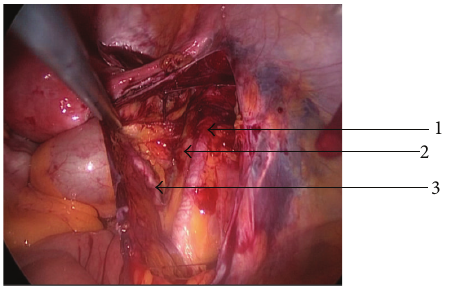
Figure 2: Retroperitoneal exposure and appearance of iliac vessels (1, 2), ureter